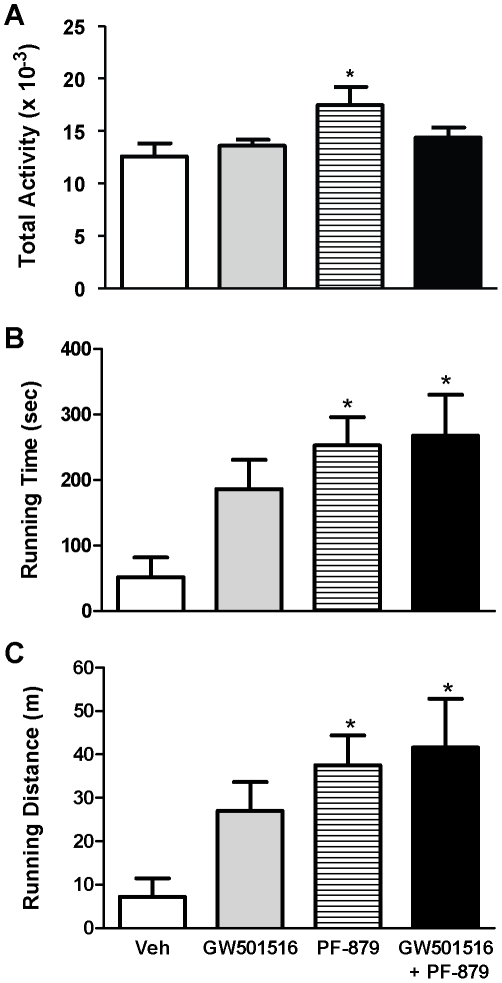
Myostatin inhibition increases habitual physical activity and improves performance in ob/ob mice.After 6 weeks of treatment with vehicle (veh), GW501516, PF-879, or GW501516 in combination with PF-879, habitual physical activity was monitored and summed for a 48 hour period (A) (n = 8/group). At study end, the time (B) and distance (C) mice were able to comply with a performance protocol on a motorized treadmill was also measured (n = 10/group). Data are represented as mean +/− SEM. * represents p<0.05.